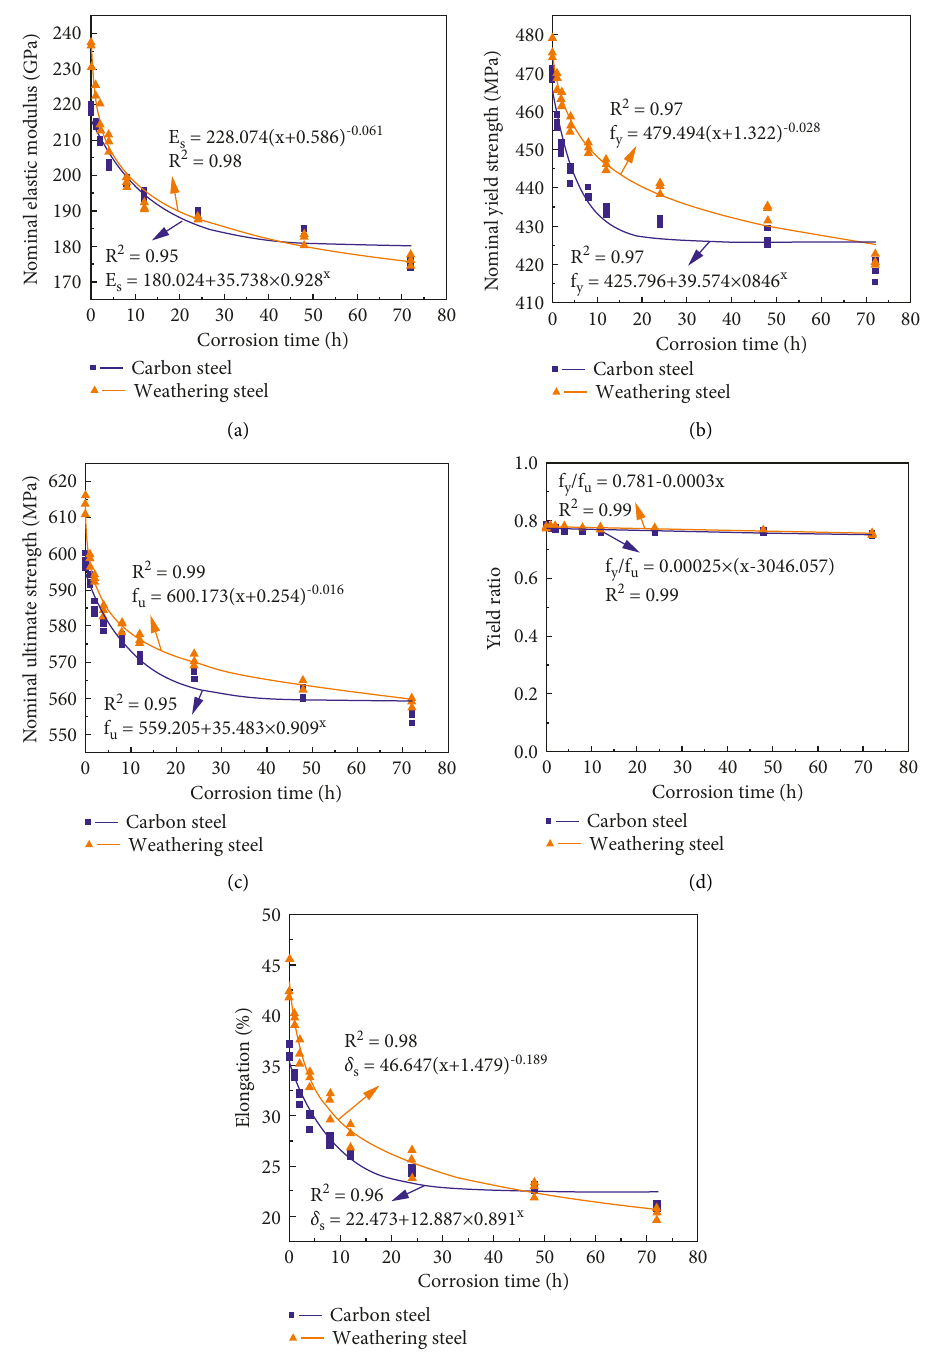
Figure 14: Performance degradation of corroded carbon steel and weathering steel. (a) Nominal elastic modulus E strength f y . (c) Nominal ultimate strength f u . (d) Yield ratio f y / f u . (e) Elongation δ s